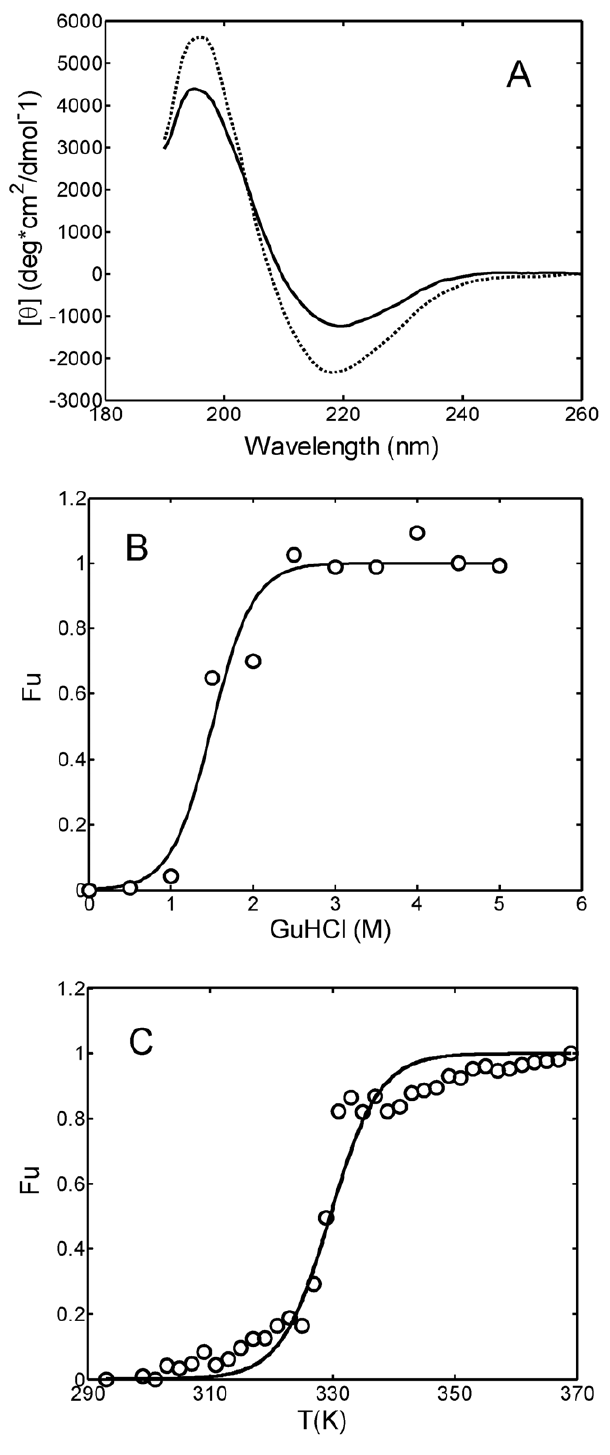
Figure 2. Light chain structural changes induced by pH, denaturant addition and temperature. (A) CD spectra for the 0.3 g/L light chain solution in 25 mM PBS at pH 7.4 (_) and in 20 mM HCl at pH 2.0 (–); (B) Fraction of unfolded protein as a function of guanidinium hydrochloride (GuHCl) concentration evaluated by intrin- sic tryptophan fluorescence measurements (see Materials and Meth- ods). The continuous line represents the interpolation of experimental data according to Eq. 1; (C) Fraction of unfolded protein as a function of temperature evaluated by CD measurements (see Materials and Methods). The continuous line corresponds to the interpolation of experimental data according to Eq.1.